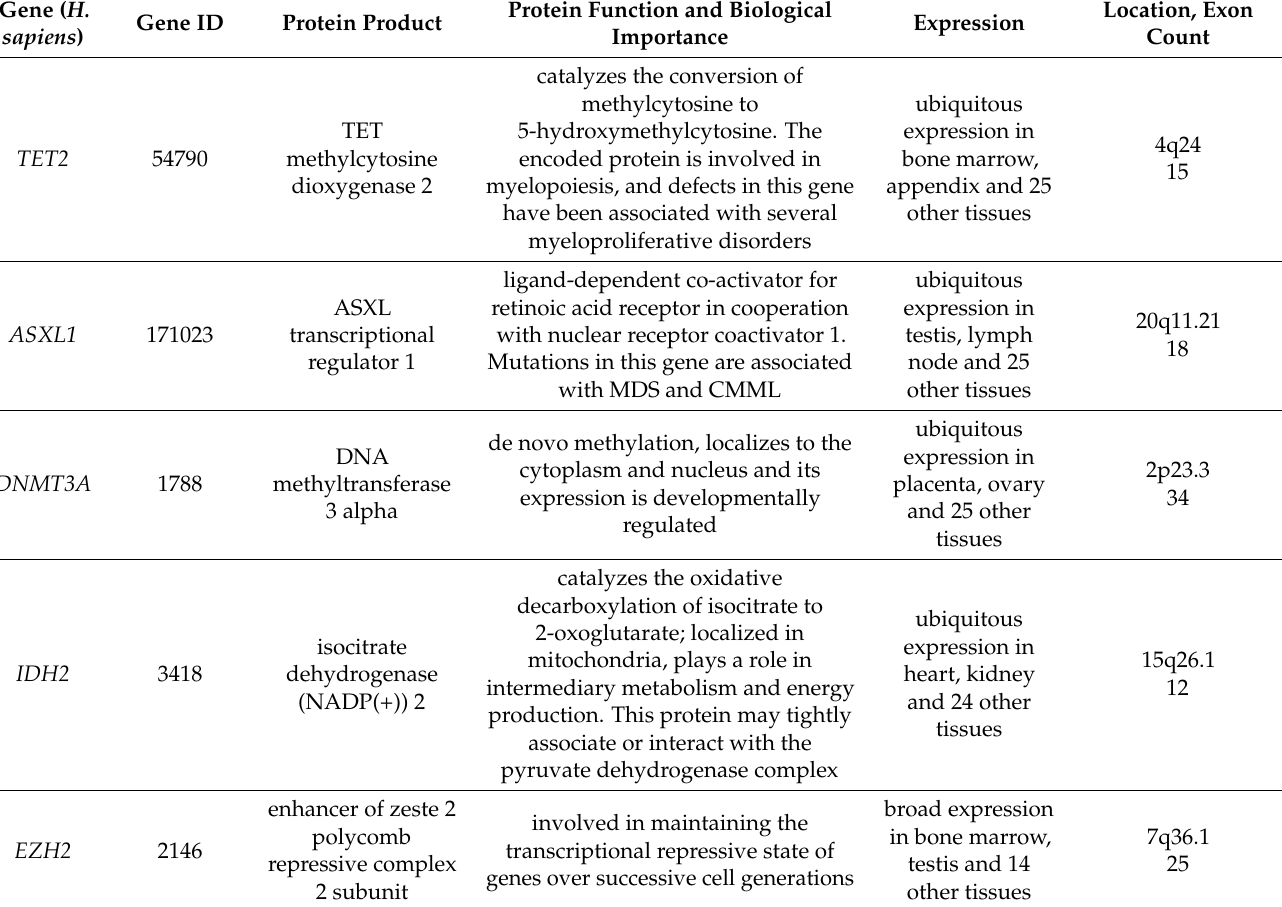
Table 1. Mutated genes related to epigenetic modification in mastocytosis 1 . Gene (